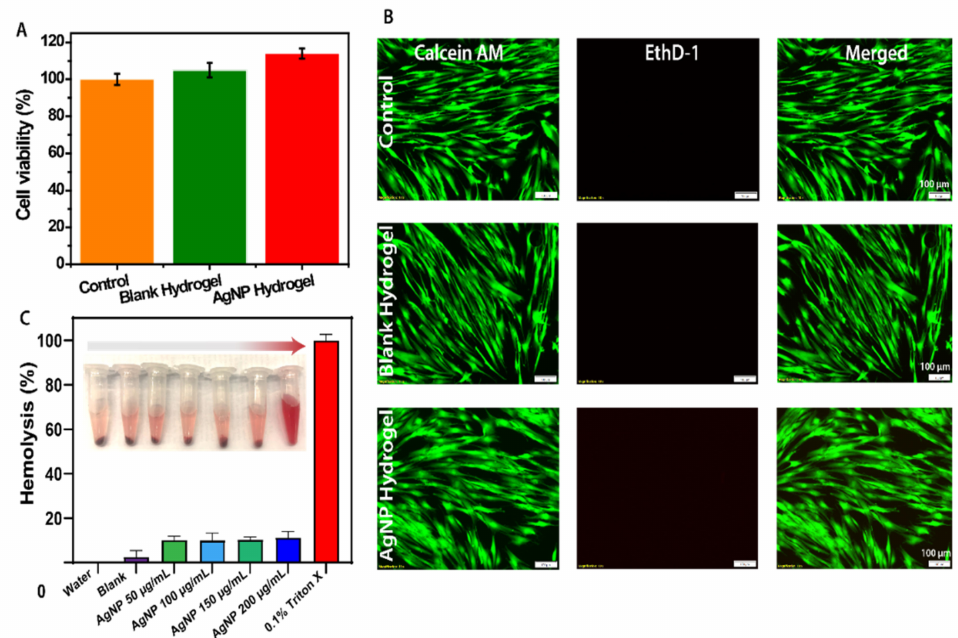
Figure 2. In vitro biocompatibility and hemocompatibility in response to treatment groups. ( A ) HFFs cell viability (%) after 24 h exposure to treatments. ( B ) Fluorescent images of live/dead assay showing cell viability. ( C ) Hemolysis (%) of red blood cells treated with different concentrations of AgNP hydrogel. Data are shown as mean ± SD. Scale bar 100 µ